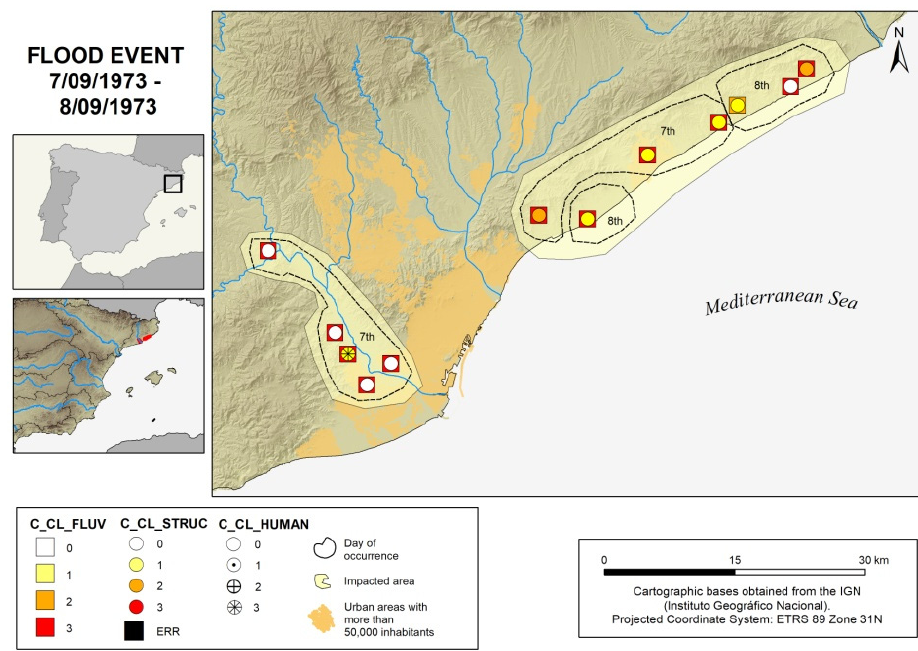
Figure 4. Representation of cases for the flood event of 7 and 8 September 1973. C_CL_FLUV: Variable 1. Hydraulic behaviour of the river flood. C_CL_STRUC: Variable 2. Flood impact on structural elements. C_CL_HUMAN: Variable 3. Social/personal vulnerability to the flood. ERR: Erroneous or spurious cases. Blue line: Basic fluvial system. Black line: Spanish Hydrographic Demarcations. Urban areas: Population according to 2022 demographic record.